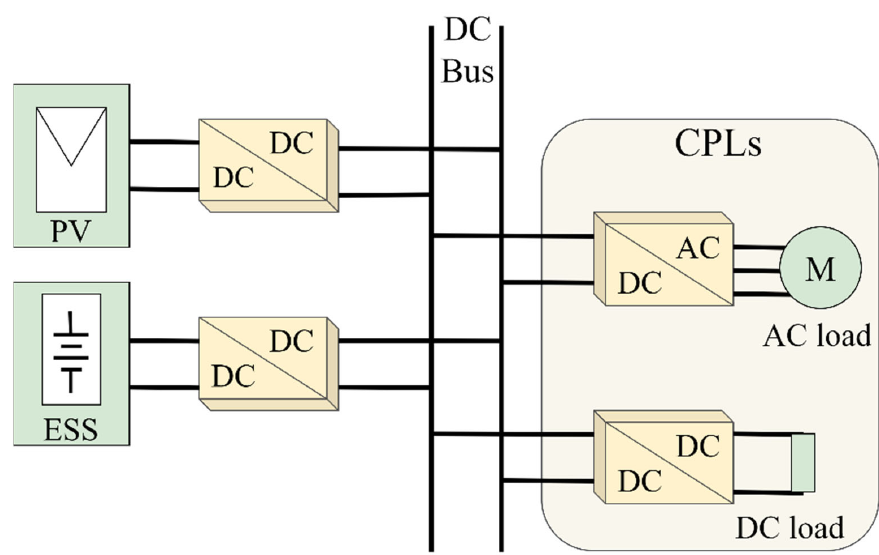
Figure 1. A typical DC microgrid with CPLs.